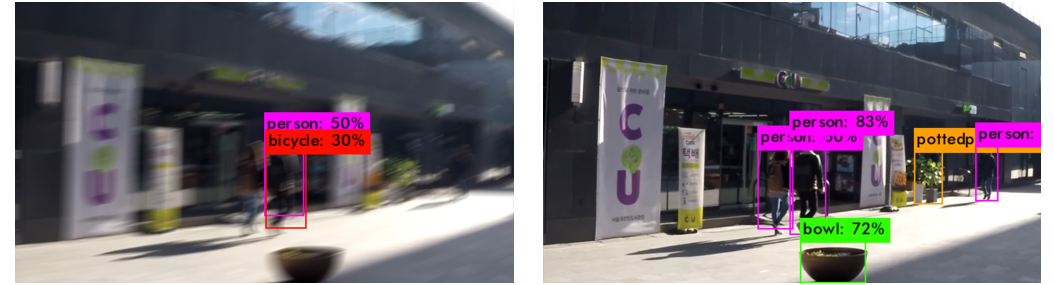
Figure 1. Object detection using YOLO [18] on the distorted ( left ) and pristine ( right ) images, taken from GoPro [19] dataset. The detection effectiveness of YOLO is remarkably impaired by the quality of the input